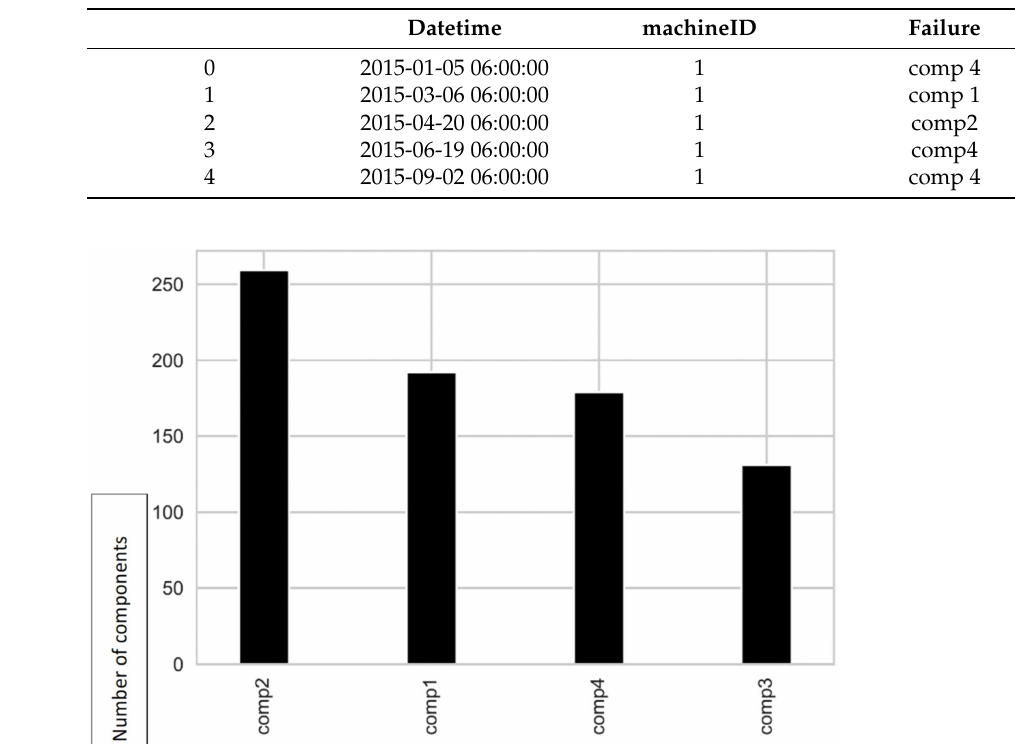
Table 5. Typical example of failure records.